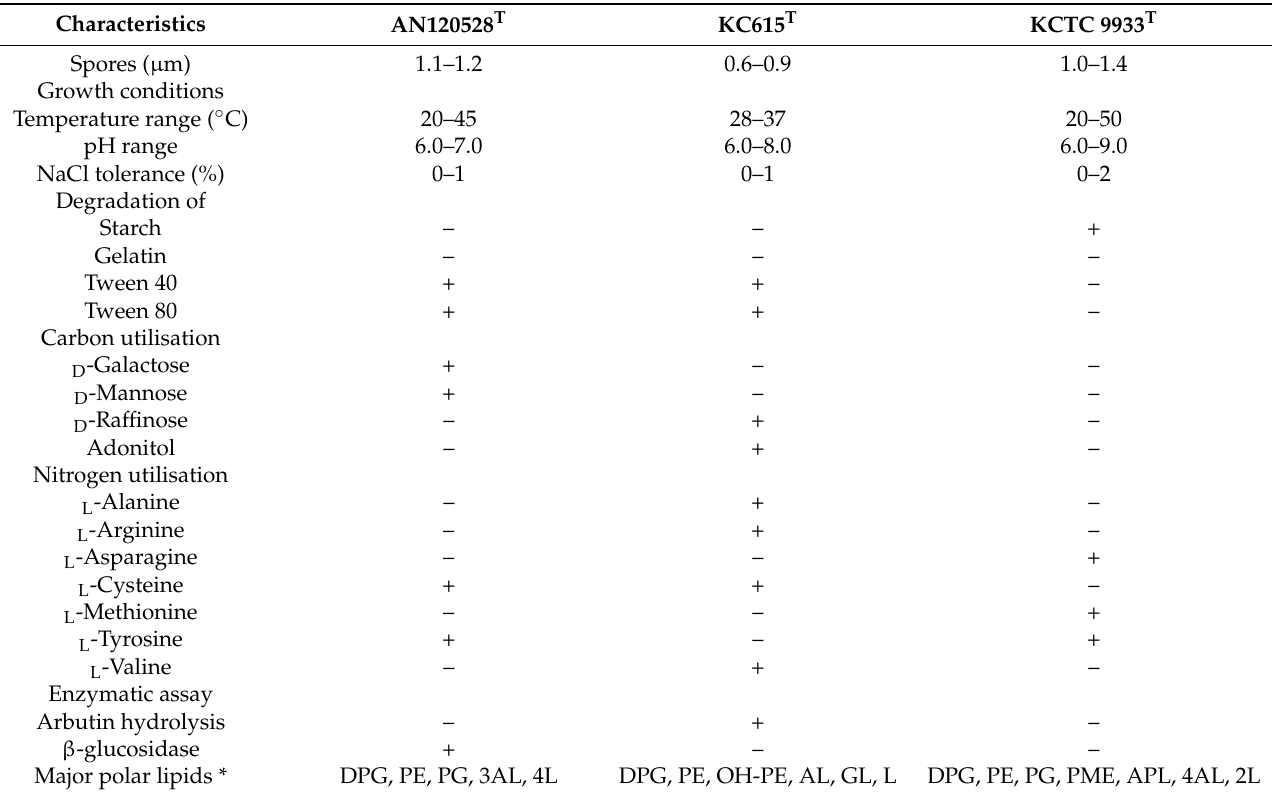
Table 1. Physiological and biochemical properties of the strain AN120528 T and related strains. All strains were gram-positive, aerobic and non-motile, and anaerobic growth was not observed. All strains also have MK-9 (H 4 ) and MK-10 (H 4 ) as respiratory quinones, meso-diaminopimelic acid as the diamino acid peptidoglycan and ribose and glucose as the major cell-wall